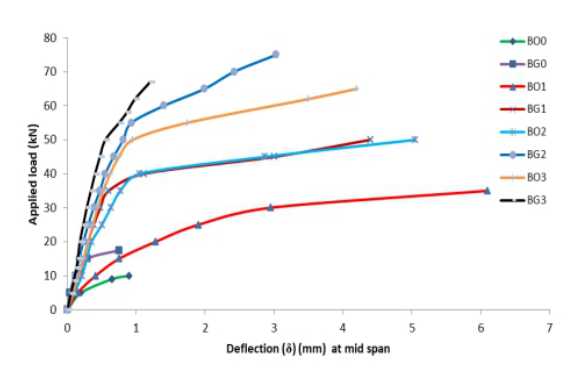
Fig. 6. Load Deflection Curves of Beams